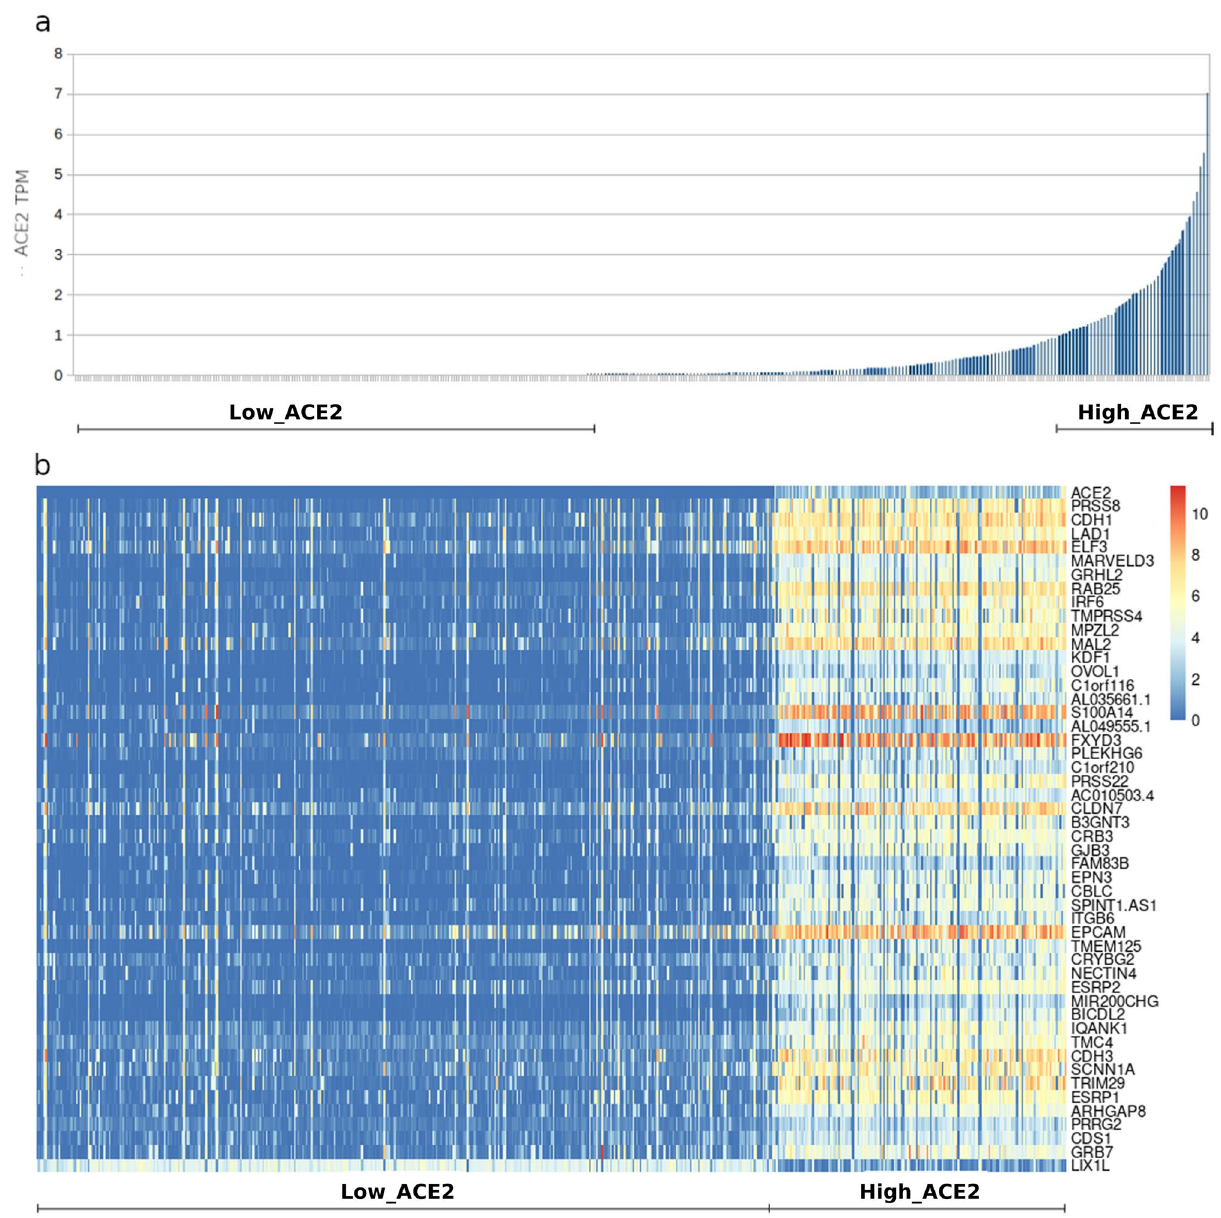
Figure 1. Building a virus-free COVID-19 disease model based on differential ACE2 expression in human cell lines. ( a ) 1305 cell lines from the Cancer Cell Line Encyclopedia (CCLE) project were sorted on the base of their ACE2 TPM (Transcripts Per Million) content. Cell lines displaying a ACE2 TPM value equal to 0 (Low ACE2) or greater than 1 (High ACE2) were grouped. ( b ) Top 50 differentially expressed transcripts between Low ACE2 vs. High ACE2 cell